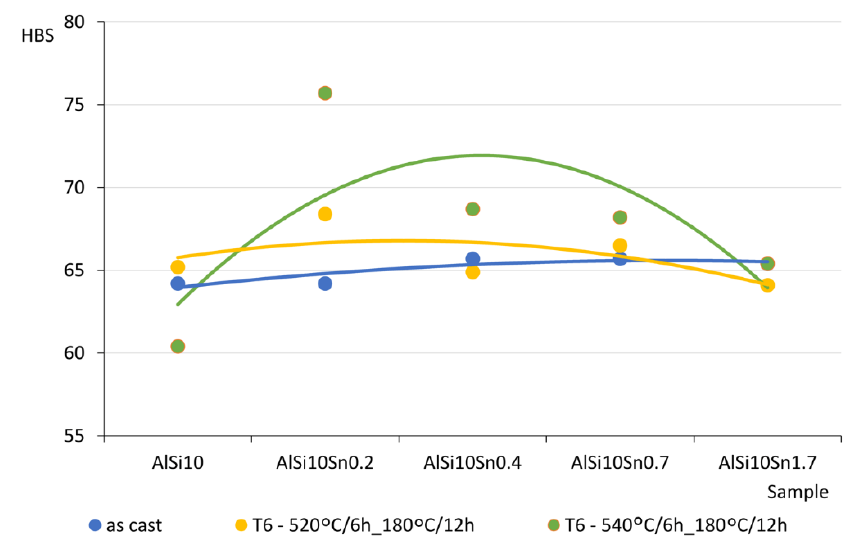
Figure 24. HB hardness test results for AlSi10 alloys with variable tin additions. Blue line—as cast; green line—T6—540 °C/6 h_180 °C/12 h; yellow line—T6—520 °C/6 h_180 °C/12 h.